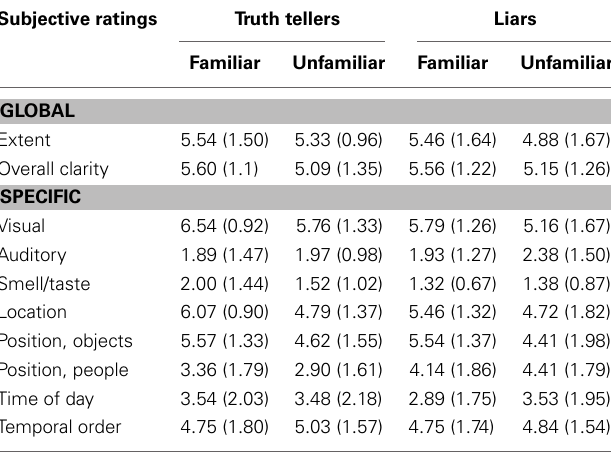
Table 3 | Means (and standard deviations) of the mental images’ vividness for Veracity and